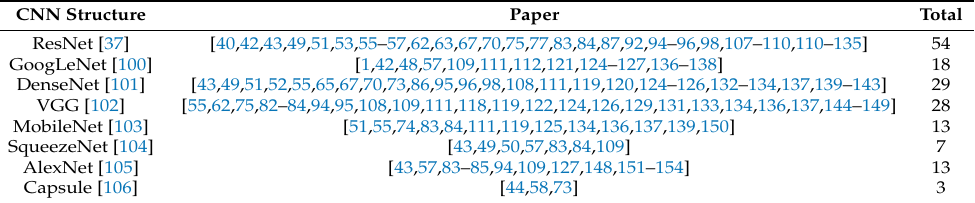
Table 4. CNNs used By COVID-19 diagnosing